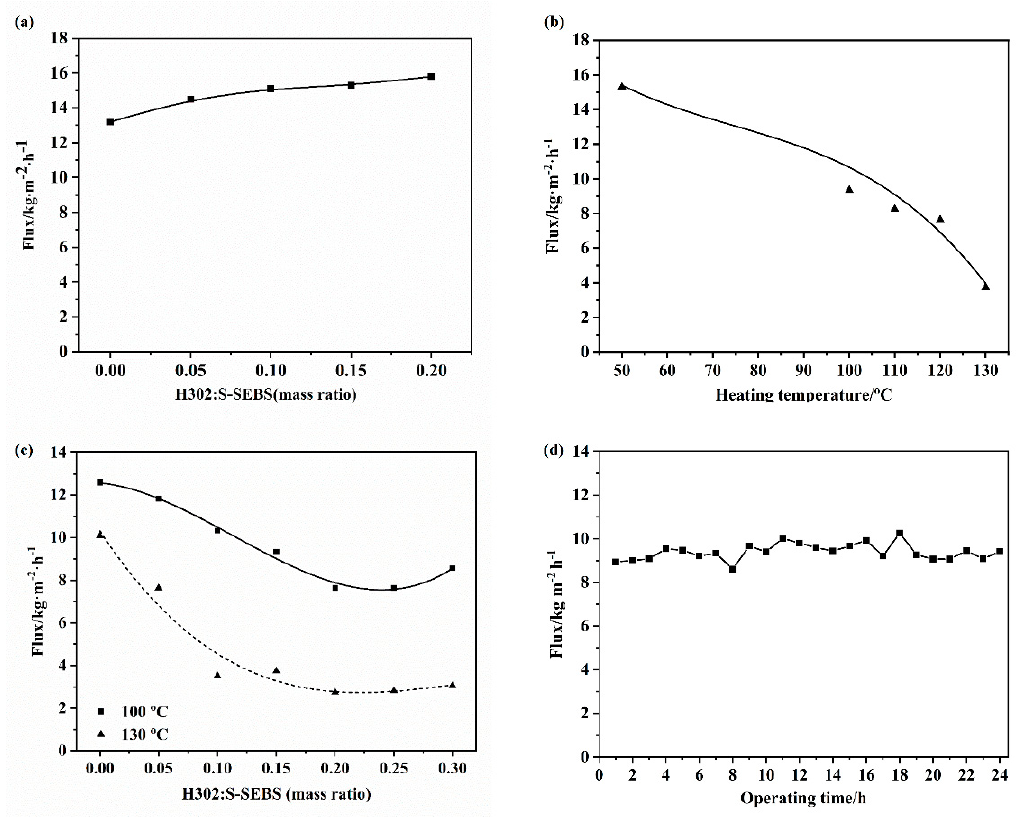
Figure 10. Pervaporation performance of ( a ) without thermal treatment; ( b ) with thermal treatment di ff erent temperatures (H302: S-SEBS = 0.15:1); ( c ) at di ff erent mass ratios of H302: S-SEBS; ( d ) stability at different temperatures (H302: S-SEBS = 0.15:1); ( c ) at different mass ratios of H302: S-SEBS; ( d ) test for membrane (H302:S-SEBS = 0.15:1, thermal treatment at 100 ◦ C). (All PV test with 5 wt% NaCl stability test for membrane (H302:S-SEBS = 0.15:1, thermal treatment at 100 °C). (All PV test with 5 feed solution at 65 ◦ wt% NaCl feed solution at 65 °C).